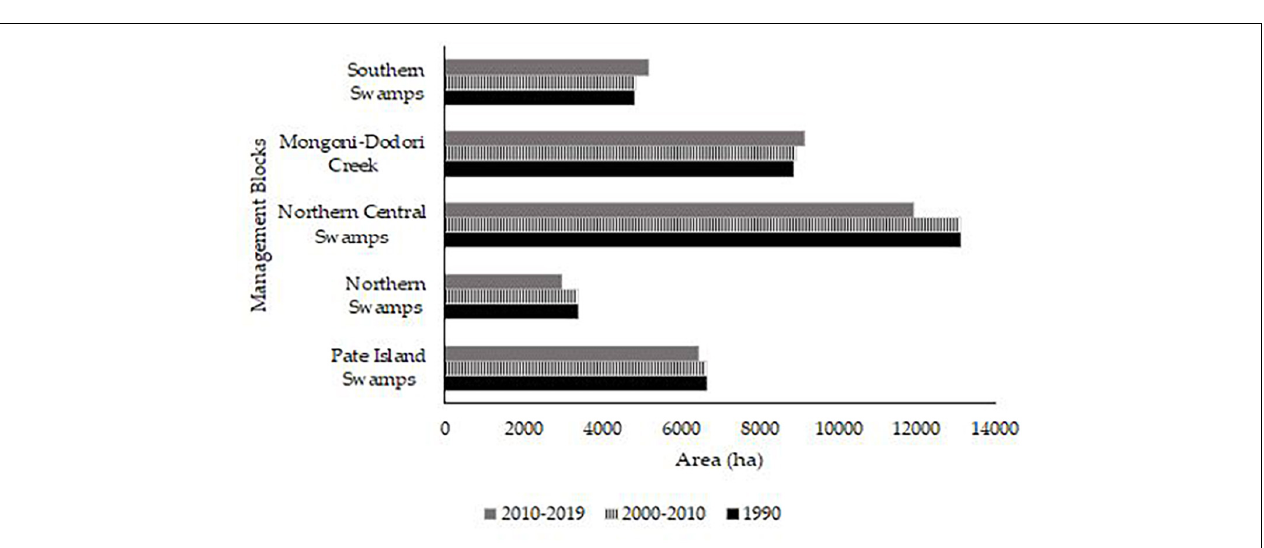
FIGURE 3 | Trends of mangrove cover change in the different management